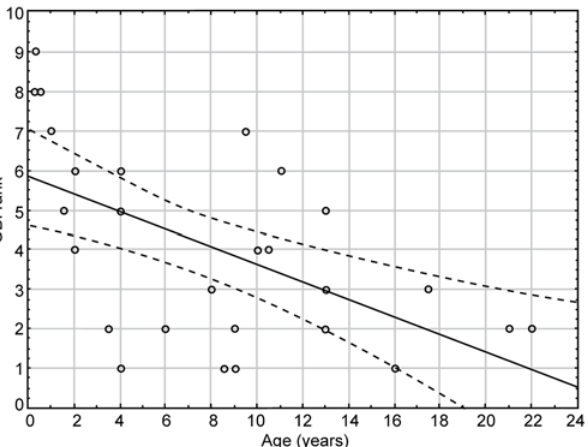
Fig 2. Rank vs. time in a herd. The CBI rank was influenced by time spent in the herd in females only (r 2 = 0.25, p = 0.017), not in males (r 2 = 0.35, p = 0.09). Note that the highest rank level is 1 (the first position in a